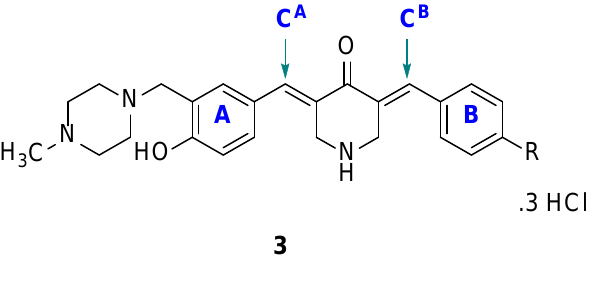
Figure 3. Structures of 3a – e .